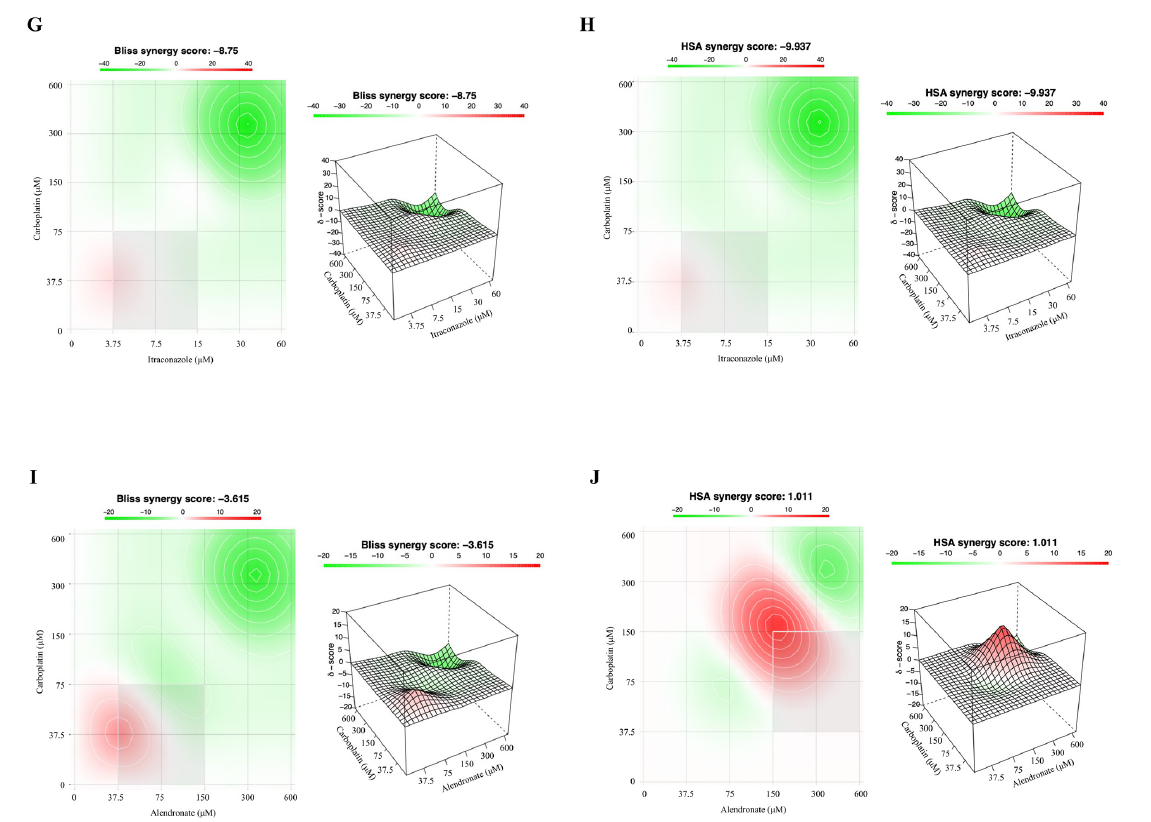
Figure 4. Combining Carboplatin with Metformin has a synergistic effect on OVCAR8 cells. ( A – J ) Bliss Independence and High Single Agent (HSA) synergy 2D and 3D plots showing drug synergism of OVCAR8 cells, after exposure to fixed dose ratios that correspond to 0.25, 0.5, 1, 2 and 4 fold the individual IC 50 values each drug, e.g., Carboplatin combined with ( A , B ) Pitavastatin, ( C , D ) Metformin, ( E , F ) Ivermectin, ( G , H ) Itraconazole and ( I , J ) Alendronate for 48 h. The combined treatment was co-administered at the same time. All assays were performed in triplicate in at least three independent experiments. Synergy score: < − 10 (antagonism, green), − 10 to 10 (additivity, white) and >10 (synergism, red).